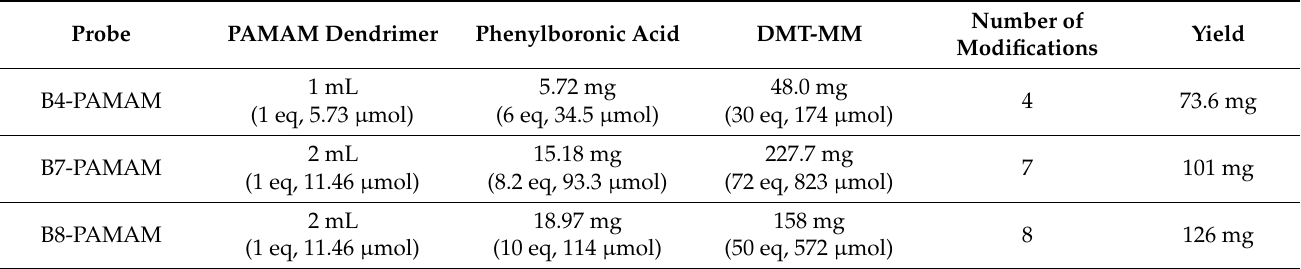
Table 1. Syntheses of B-PAMAM